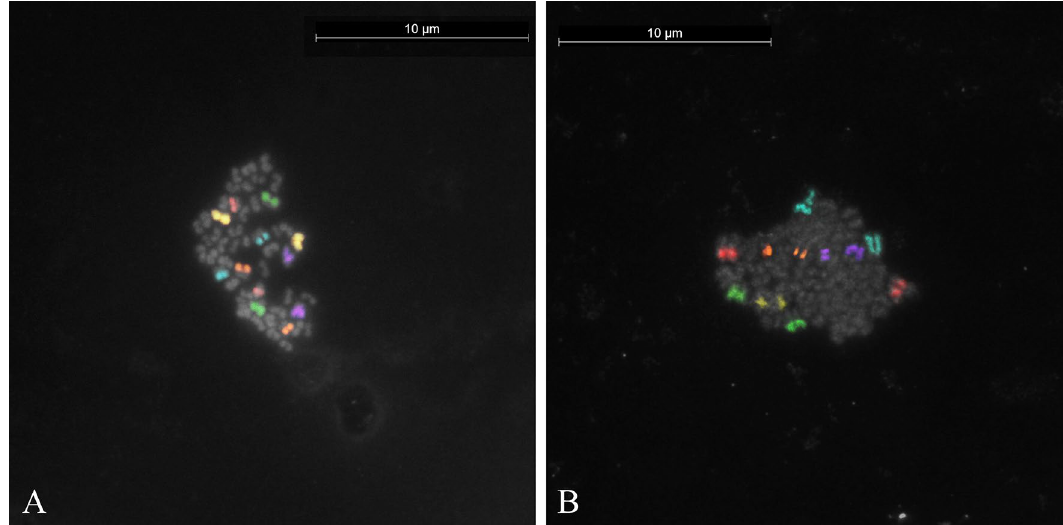
Figure 4. Unreduced secondary oocyte metaphases in ( A ) river buffalo (MII,50,XX); ( B ) swamp buffalo (MII,48,XX).